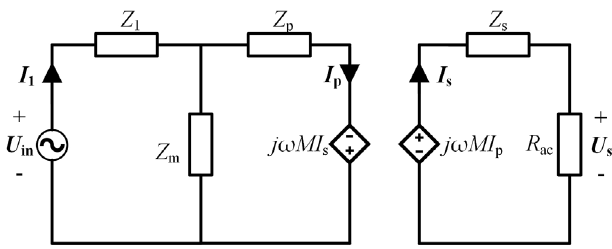
Figure 3. Simplified circuit diagram of the LC/S compensated IPT system.